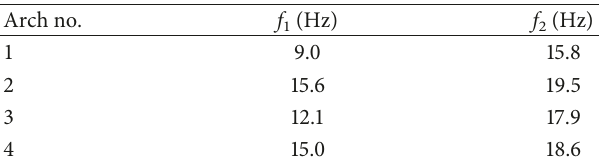
Table 3: First two natural frequencies obtained from dynamic in situ tests on arches. Arch